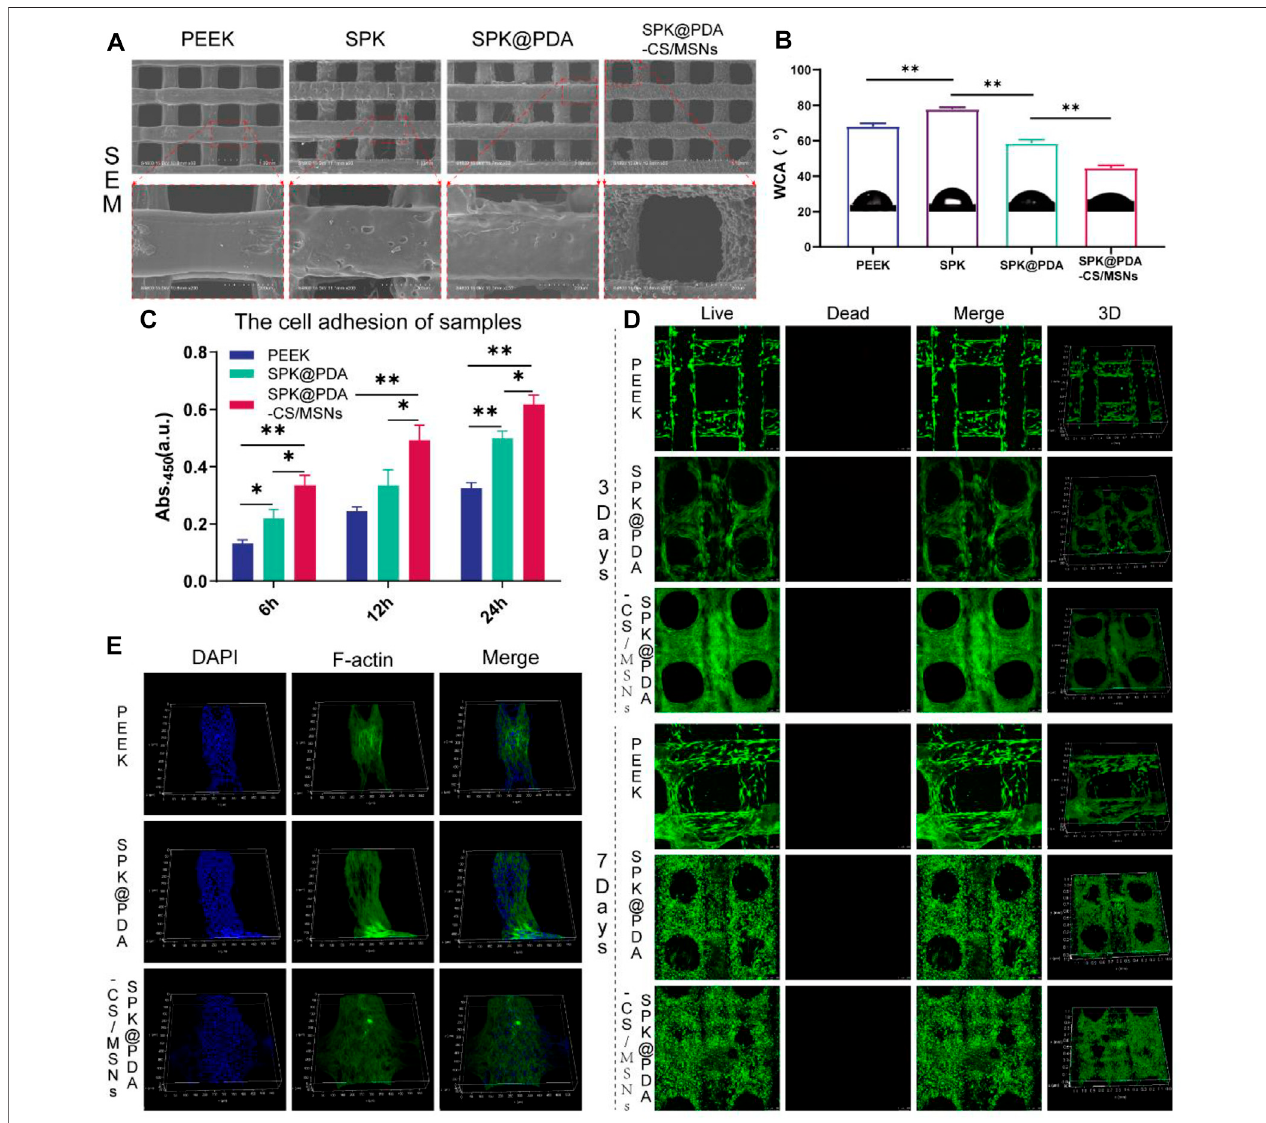
FIGURE 4 | The properties and cytocompatibility of the prepared scaffolds. (A) The SEM images of the PEEK, SPK, SPK@PDA, and SPK@PDA-CS/MSNs scaffolds. (B) The water contact angle (WCA) of the prepared specimens. (C) The cell adhesion of the PEEK, SPK@PDA, and SPK@PDA-CS/MSNs scaffolds. Data are presented as mean ± SD, n = 5, * p < .05, ** p < .01. (D) Live/Dead staining. (E) Three-dimensional fl uorescence images of BMSCs on the scaffolds for 3 days of